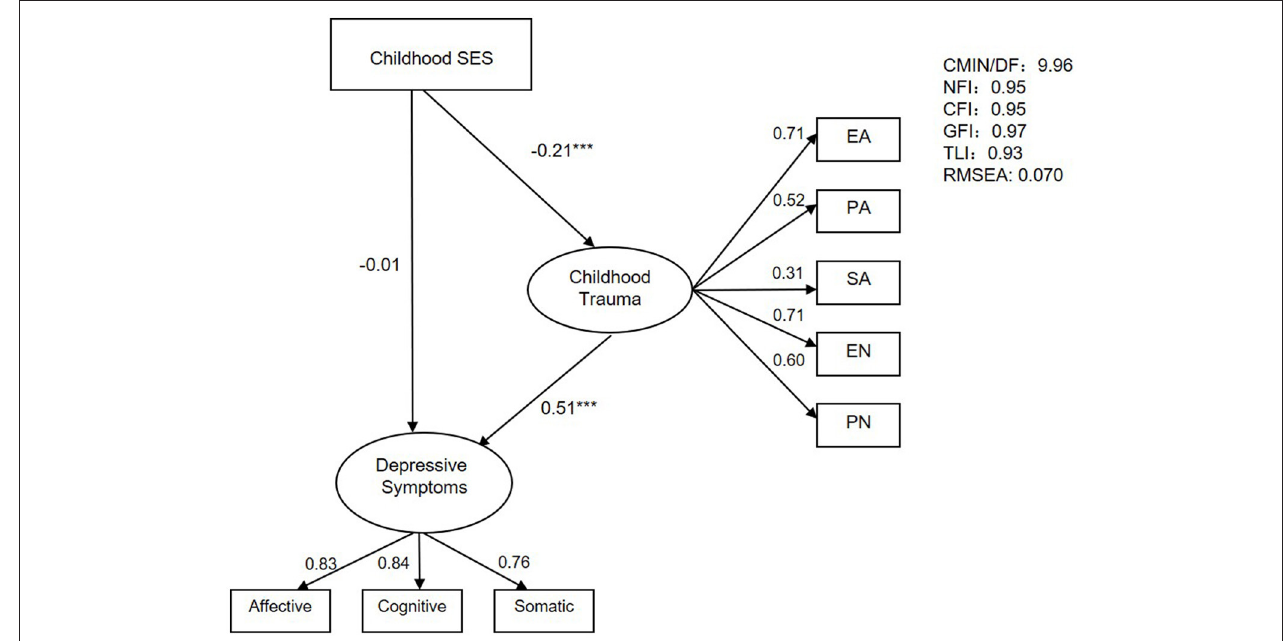
FIGURE 1 | The SEM of the mediating effect of childhood trauma on childhood SES and depressive symptoms. *** p <